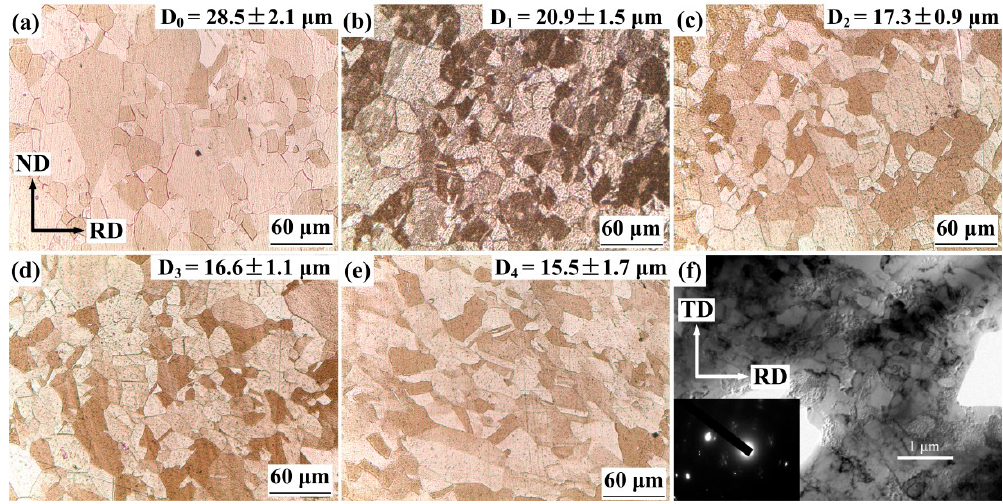
Figure 5. Microstructure evolution of nickel sheets during CGP in scheme 2: ( a ) As-annealed; ( b ) pass 1; ( c ) pass 2; ( d ) pass 3; ( e ) pass 4; ( f ) pass 4 (TEM micrograph with selected-area electron diffraction (SAED) patterns). D 0 , D 1 , D 2 , D 3 and D 4 indicate the estimated grain sizes.